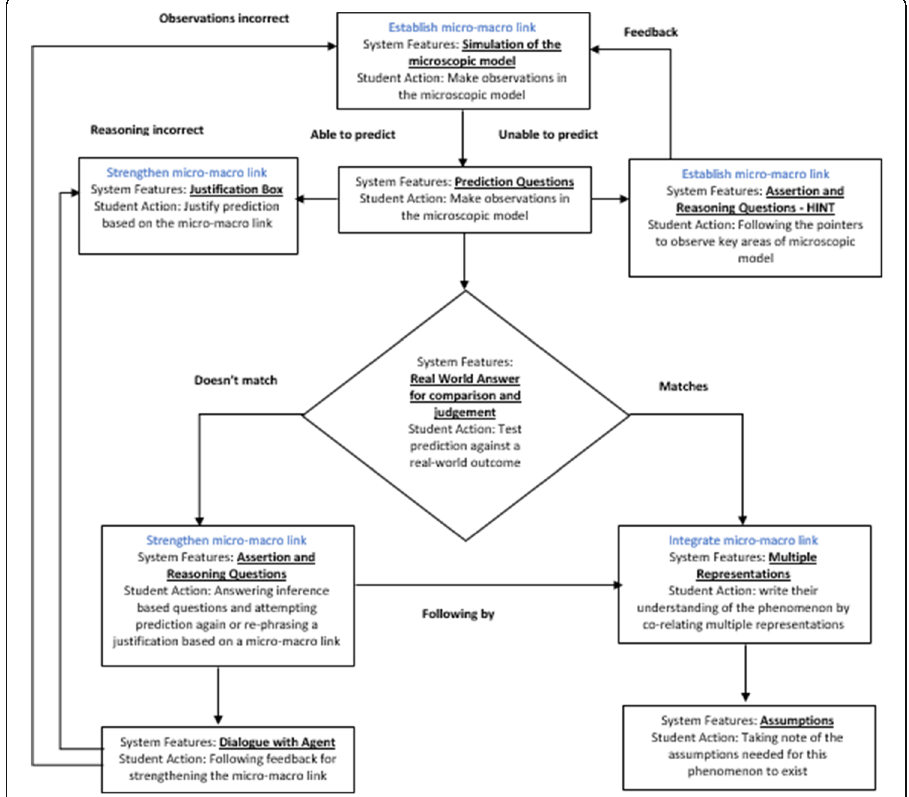
Fig. 2 Overview of the TEL environment and local instructional